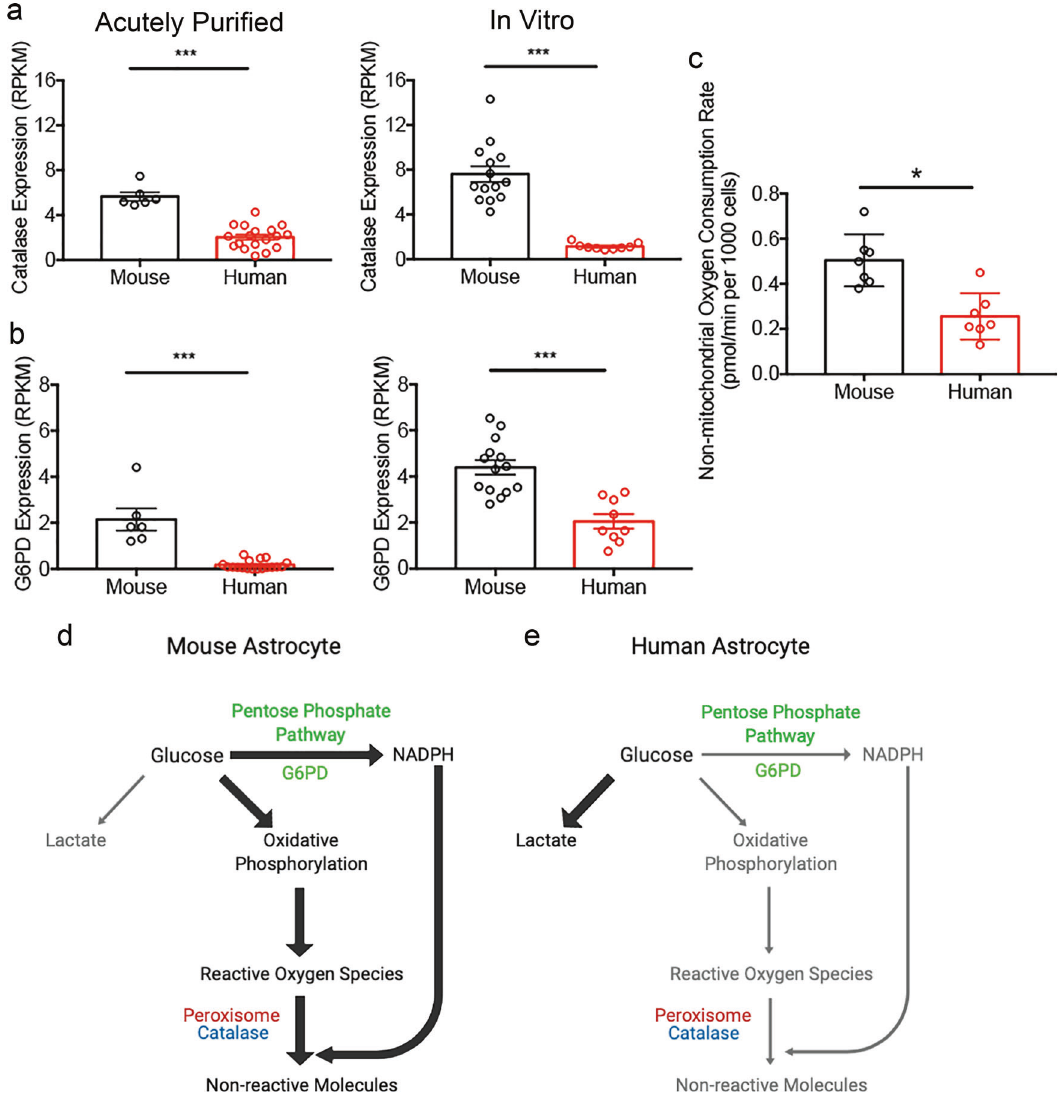
Fig. 5 Detoxi fi cation pathway differences between human and mouse astrocytes. a , b Expression of ROS detoxi fi cation pathway genes catalase ( a ) and glucose-6-phosphate dehydrogenase (G6pd in human/G6pdx in mouse) ( b ) by acutely puri fi ed astrocytes and serum-free cultures of astrocytes determined by RNA-seq. N = 6 litters of mice and 18 human patients for acutely puri fi ed samples. N = 14 litters of mice and 9 human patients in vitro. Acutely puri fi ed: Catalase, p < 0.0001; G6PD, p < 0.0001, two-tailed Mann-Whitney test. Serum-free cultures: Catalase, p < 0.0001; G6PD, p < 0.0001. Two-tailed unpaired Welch ’ s t-test, unless otherwise indicated. Samples include children and adult patients as well as developing and adult mice. The ages of the patients and mice are listed in Supplementary Data 8. c Non-mitochondrial OCR measured in the presence of antimycin-A. N = 7 wells of cultured cells from each species generated from 4 litters of mice and 3 patients. p = 0.0126. Two-tailed unpaired Welch ’ s t-test. The p -values were calculated using average results from each litter of mice and each patient as independent observations. d , e Model of glucose metabolism and detoxi fi cation pathways in human and mouse astrocytes. The widths of the arrows represent the rate of the metabolic processes. Mouse astrocytes have higher rates of oxidative phosphorylation, which presumably produce more ROS than human astrocytes. The higher abundance of detoxi fi cation pathway genes and the higher peroxisomal activity in mouse compared to human may protect the cells against oxidative new world alpha viruses, and some fl aviviruses (e.g., Zika virus), are capable of infecting CNS cells, inducing neuroin fl ammatory responses, and causing acute or long-lasting neurological de fi cits 47,48 . Astrocytes, along with microglia, are CNS-resident cells that modulate neuroin fl ammation. However, responses of human astrocytes to viral infections and their consequences to CNS homeostasis and function are poorly understood. In addi- tion to viral infections, neuroin fl ammation is a core pathological component of a range of neurological conditions such as trau- matic injury, stroke, neurodegeneration, and aging. tumor necrosis factor alpha (TNF α ) is a major pro-in fl ammatory